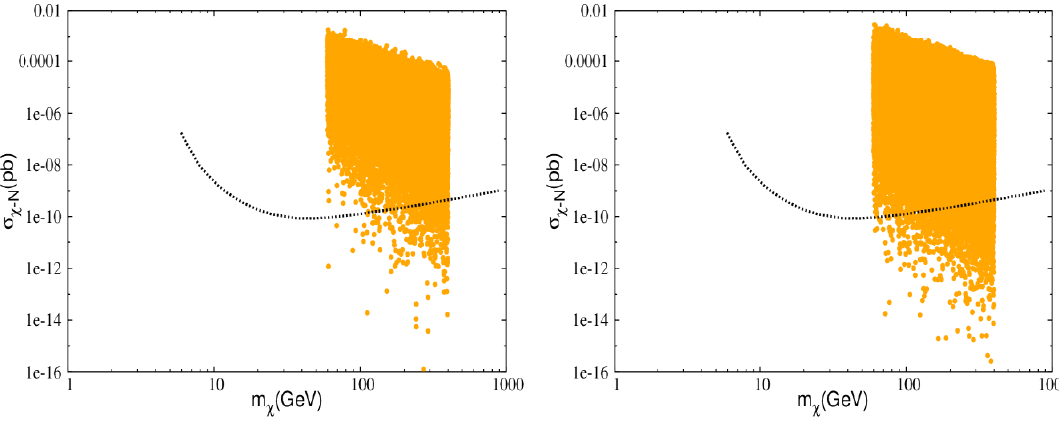
Figure 1 . Parameter space allowed by the relic density observation for Type I (left) and Type II (right) 2HDM. The black dashed line is the upper limit on the χ XENON1T